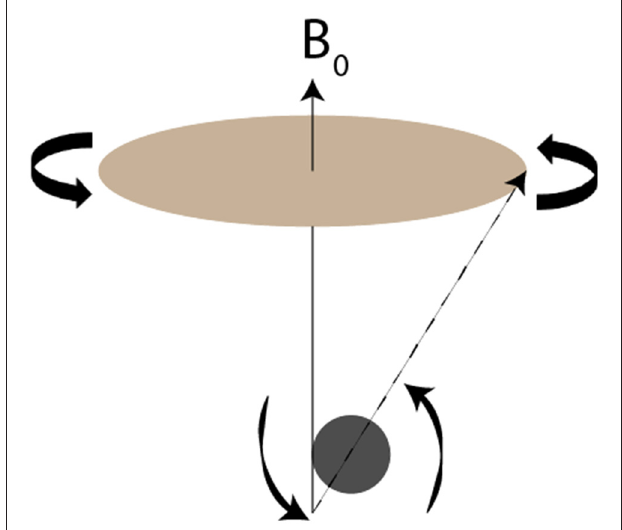
FIGURE 1 | Visual demonstration of precession. Redrawn from Figure 2 of Jackson et al. (2005). The nucleus’s axis of rotation (dotted line) does not exactly align with the magnetic field B 0 (solid line). As the nucleus rotates around the B 0 , it also spins on its own axis. The frequency with which the nucleus rotates around B 0 , termed the precession, is inherent to each species and scales linearly with the strength of the magnetic field.